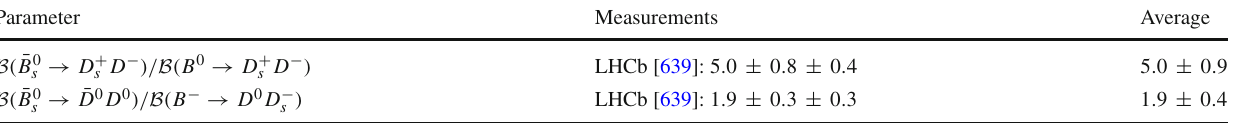
Table 194 Relative decay rates II [ 10 − 2